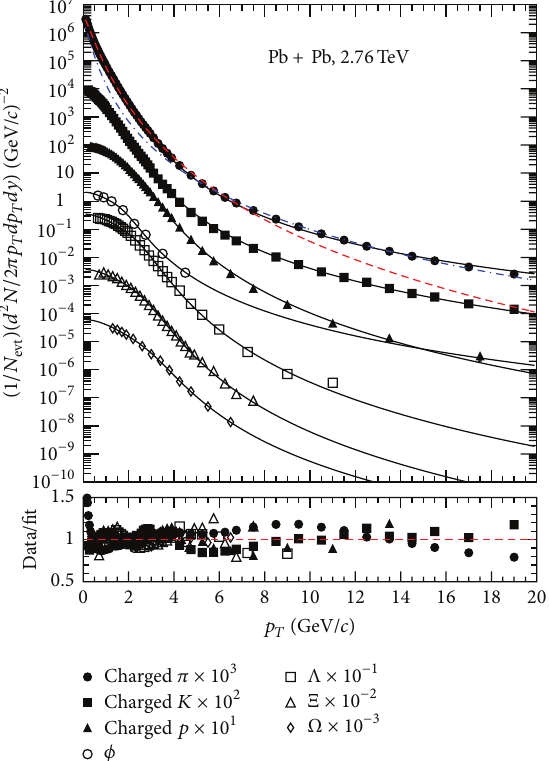
Figure 6: The data are from [33, 53–55] for Pb + Pb at √𝑠 𝑁𝑁 = 2 . 76 TeV. The red dashed line is the results fitting the low 𝑝 𝑇 region and the blue dotted-dashed line is the results fitting the high 𝑝 𝑇 region using (10). The solid curves are the analytical results with (12). The corresponding fitting parameters and 𝜒 2 /ndf are given in Table 2. For a better visualization both the data and the analytical curves have been scaled by a constant as indicated. The ratios of data/fit are shown at the